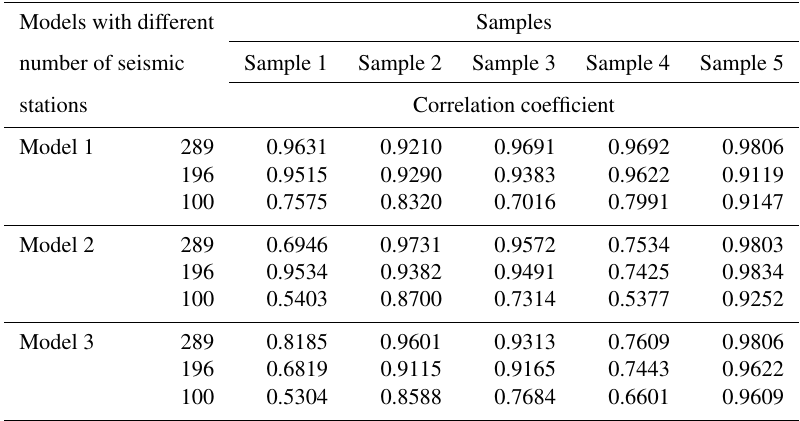
Table 2. Monitoring results of the different